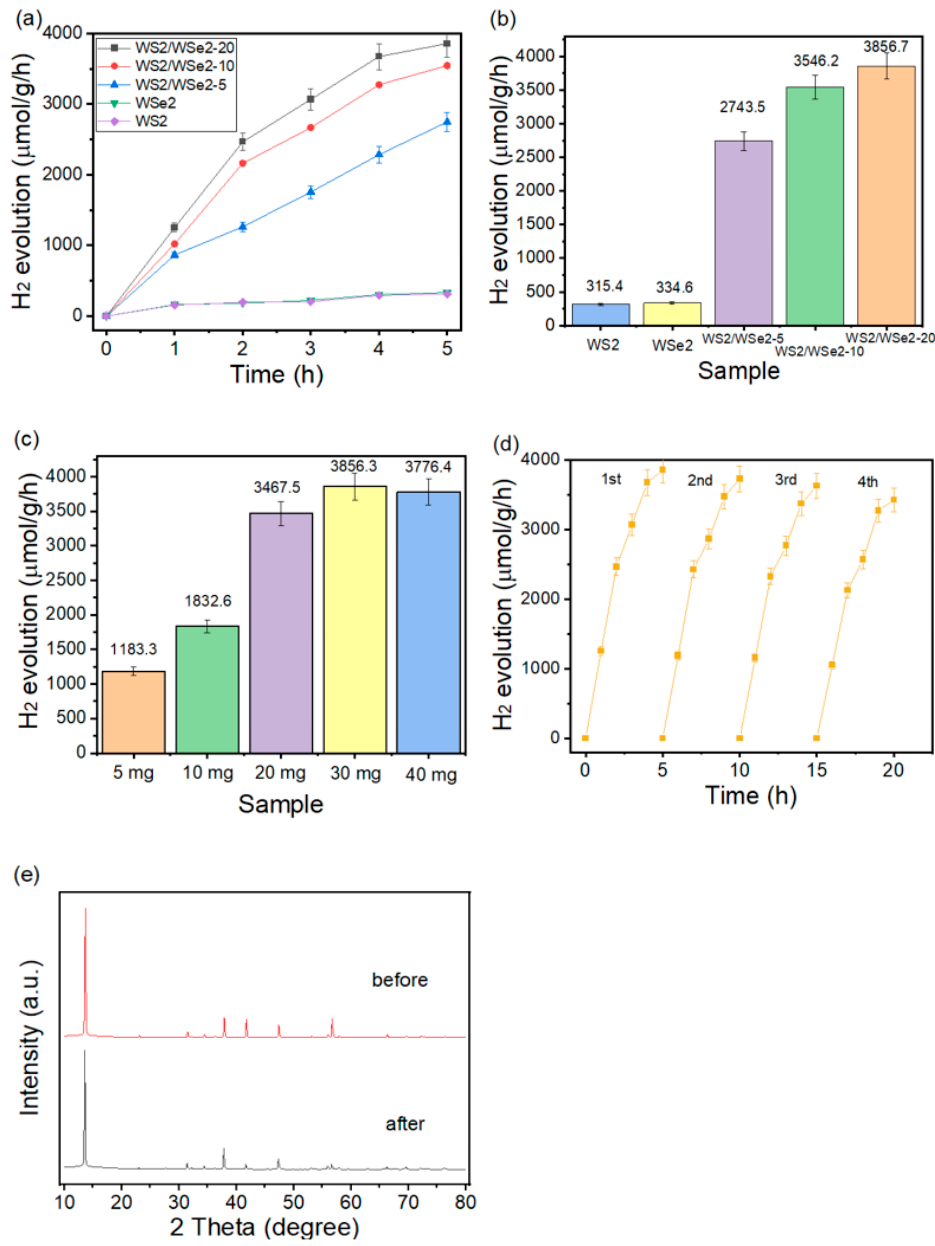
Figure 4. H 2 evolution of ( a ) WS 2 , WSe 2 , and WS 2 /WSe 2 -20 and H 2 production comparison of ( b ) WS 2 /WSe 2 -5, WS 2 /WSe 2 -10, and WS 2 /WSe 2 -20. ( c ) H 2 production with various usage amounts of WS 2 /WSe 2 -20. ( d ) H 2 production of the cycling performance, ( e ) XRD analysis of WS 2 /WSe 2 -20 before and after the hydrogen production activity.